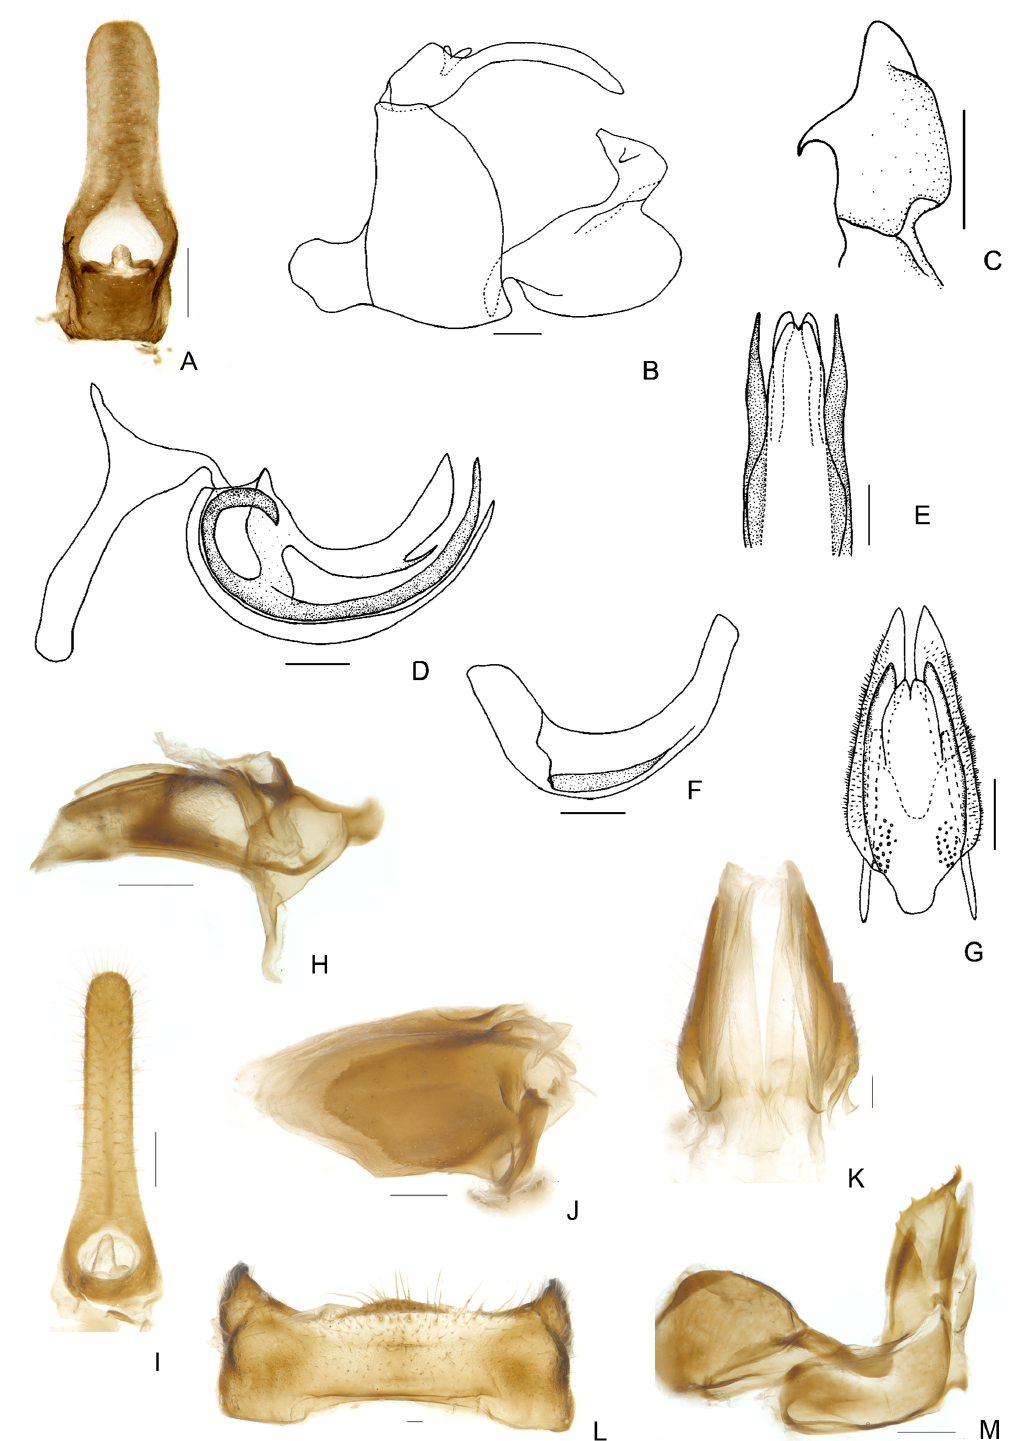
Fig. 5. Orbita parallelodroma Meng & Wang, gen. et sp. nov. — A–F . Holotype. A . Male anal tube, dorsal view. B . Male genitalia, lateral view. C . Capitulum of style, dorsal view. D . Phallobase, left view. E . Phallobase, apical half, ventral view. F . Aedeagus, left view. — G . gonapophyses IX and gonaspiculum bridge, dorsal view. H . gonapophyses IX and gonaspiculum bridge, right view. I . Female anal tube, dorsal view. J . gonoplac, left view. K . gonoplac, dorsal view. L . Sternum VII, ventral view. M . gonocoxa VIII and gonapophysis VIII, right view. Scale bars = 0.2